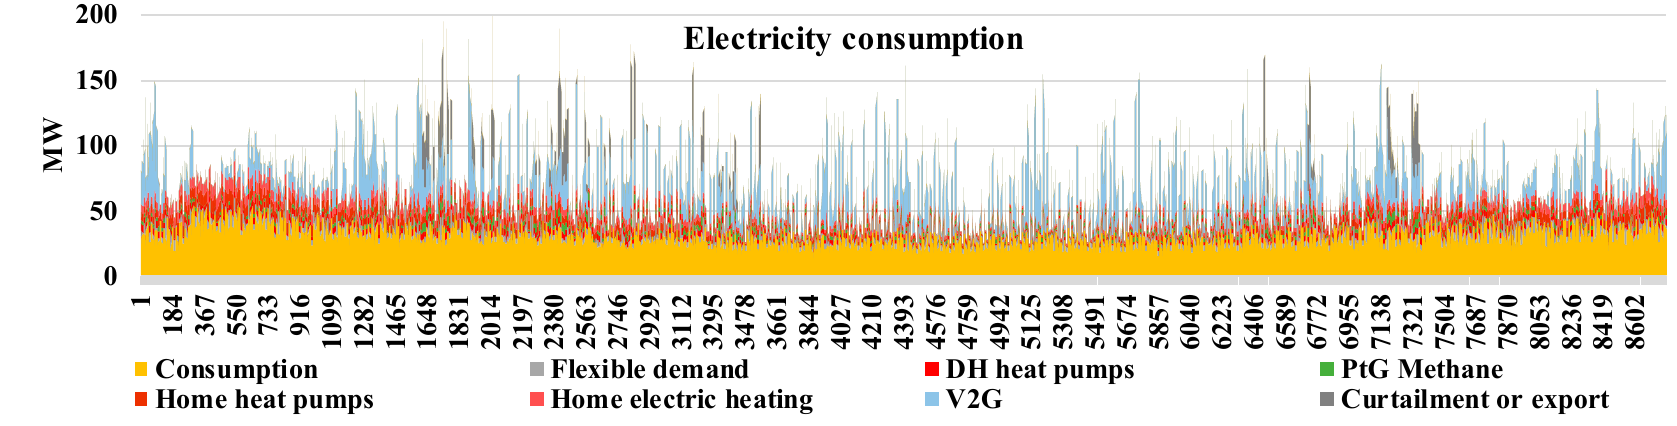
Figure 2. Annual hourly power demand by category (MW e ). Flexible demand and electric vehicle charging enables a reduction in high peaks of electricity demand and fills valleys in demand during midday and night hours. Total curtailment of electricity is less than 3.5%.